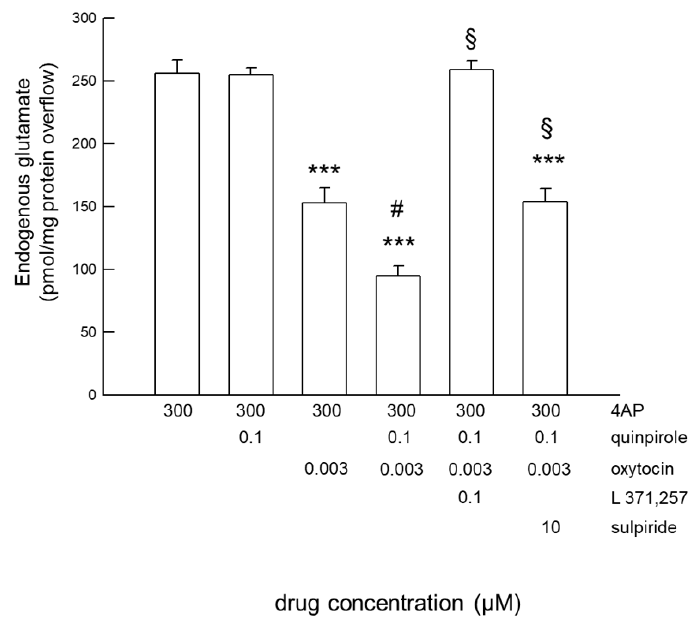
Figure 3. Functional D2-OT receptor-receptor interaction in striatal gliosomes. Effect of quinpirole 0.1 µ M on the 4-AP-evoked endogenous glutamate release in the absence and in the presence of OT 3 nM; unmasking a response to quinpirole 0.1 µ M in the presence of OT 3 nM; antagonism by sulpiride and L 371,257. Bars represent the endogenous glutamate overflow in the presence of the drugs at the concentrations indicated. 4-AP was added (6 min) during superfusion; OT and/or quinpirole was added together with 4-AP. The antagonists were added 8 min before the agonists. Other experimental details are in Materials and Methods. Data are means ± SEM (bars) of n = 3–7 independent experiments. *** p < 0.0001 compared with the effect of 4-AP; # p < 0.01 vs. 4-AP + OT; § p < 0.01 vs. 4-AP + quinpirole + OT according to one way ANOVA plus multiple